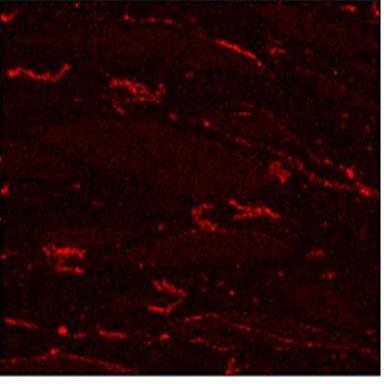
The EDS elemental mapping analysis results for the structure of accumulative fold-forged Mg/Ni composite material, indicating the composition of Mg-matrix and Ni-foil layers.